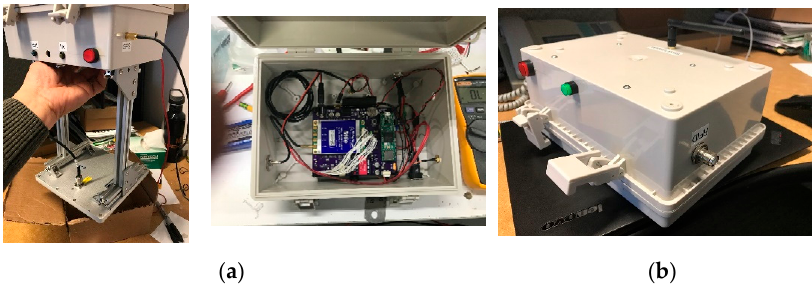
Figure 3. ( a ) RFID enclosures, antenna, and ( b ) connector for GPS and transceivers. The RFID-RM can be powered by a single Lithium Polymer battery with at least 1000 mAh from 9 V~16 V. The battery used was a 12 V with 2200 mAh (3 Cell).